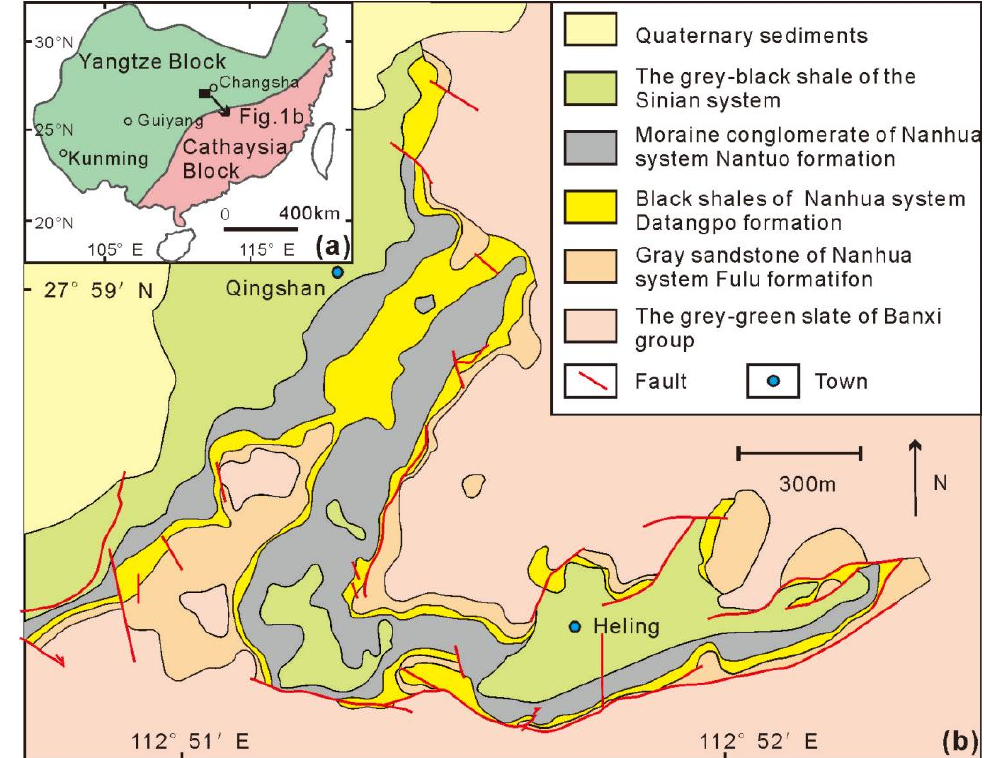
Figure 1. Tectonic sketch map of South China and the location of the study area ( a ) and geological sketch map of the Xiangtan manganese deposit ( b ).